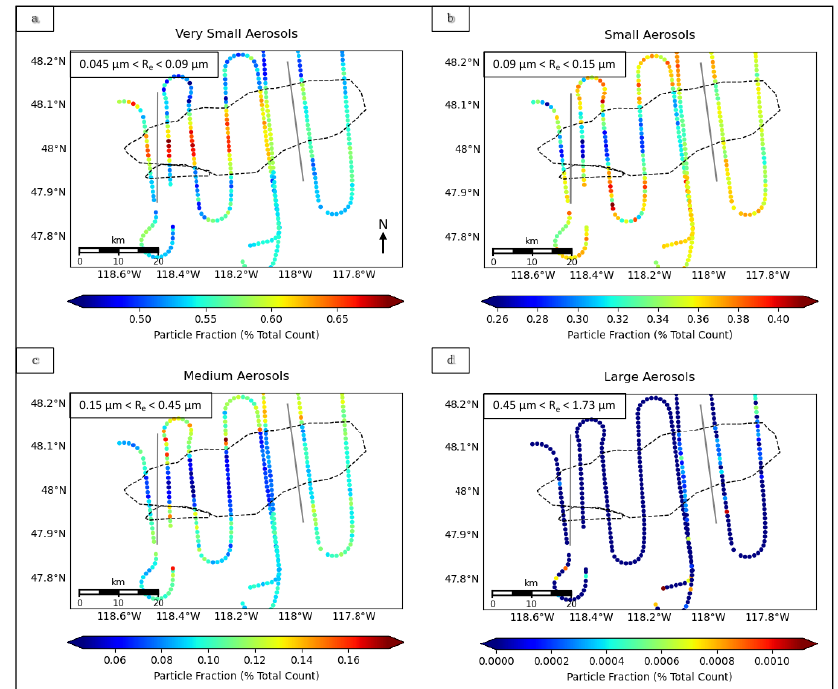
Figure 8. Fractional contributions (from zero to one) to the total aerosol count for very small ( a ), small ( b ), medium ( c ), and large ( d ) aerosols in the Williams Flats Fire, as measured by the LAS in situ instrument on 06 August 2019. The grey lines represent the boundaries between regions defined in Figure 1. Note: Approximate size ranges are given in the corner each plot, and the scales differ between categories.